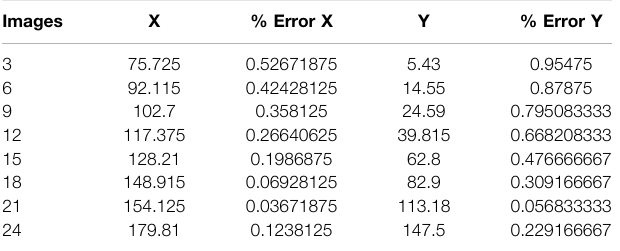
TABLE2| Comparativetablebetweenthecentersoftherealimageretrievedfrom Curie and those of the matrix (best values highlighted in green). Images